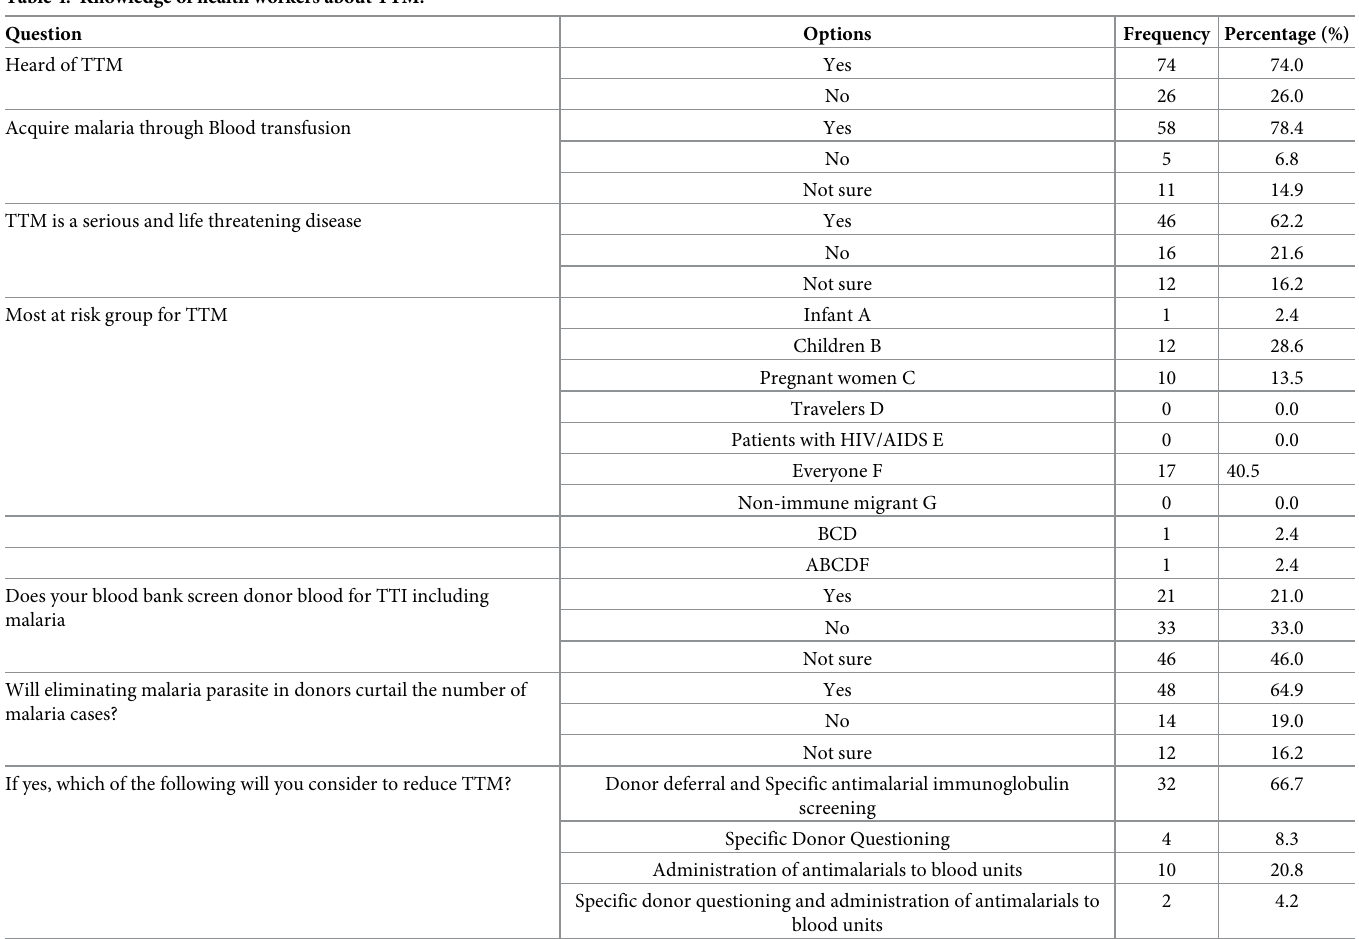
Table 4. Knowledge of health workers about